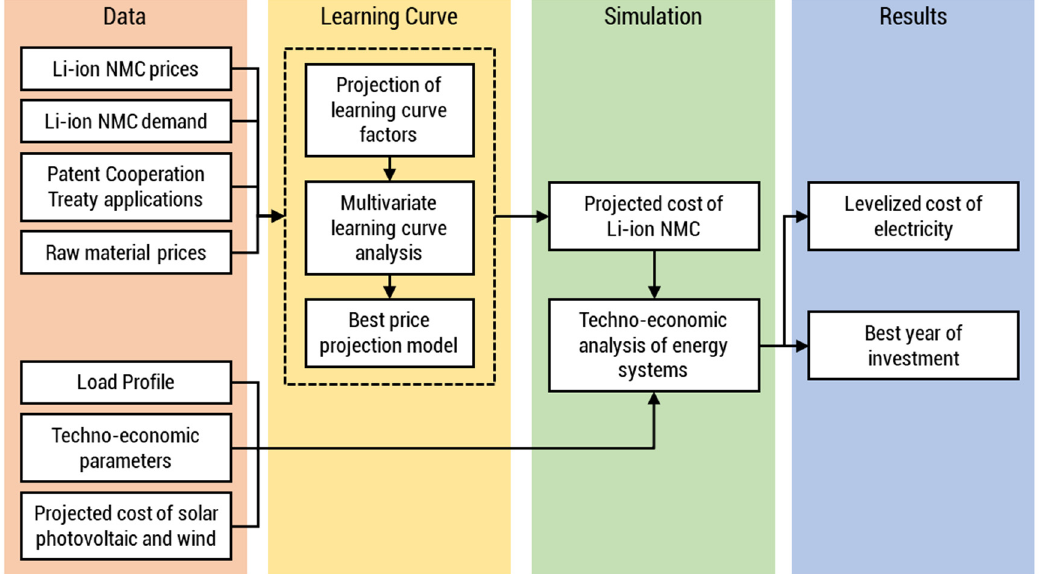
Figure 1. Flowchart of the general research approach. Li-ion nickel manganese cobalt oxide (NMC) prices, demand, patent applications, and raw material prices are used to generate the best cost projection model. The load profile of the off-grid island and commercial establishment, projected costs of energy generators and Li-ion NMC, and other techno-economic parameters are required in the analysis with HOMER Pro ® . The results are then used to determine the optimum levelized cost of electricity (LCOE) and the best year to invest in renewable energy (RE)-based generation.